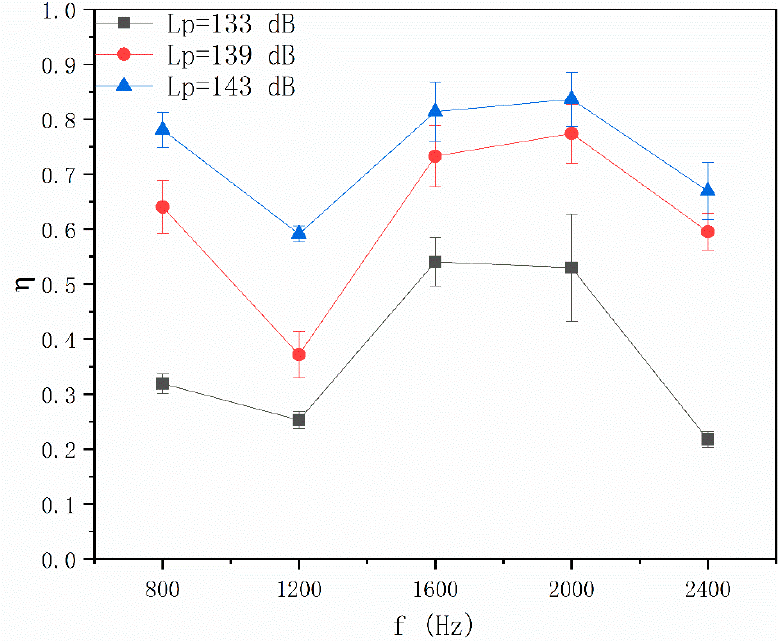
Figure 10. Reduction ratios of 4- μ m particles under different acoustic conditions.